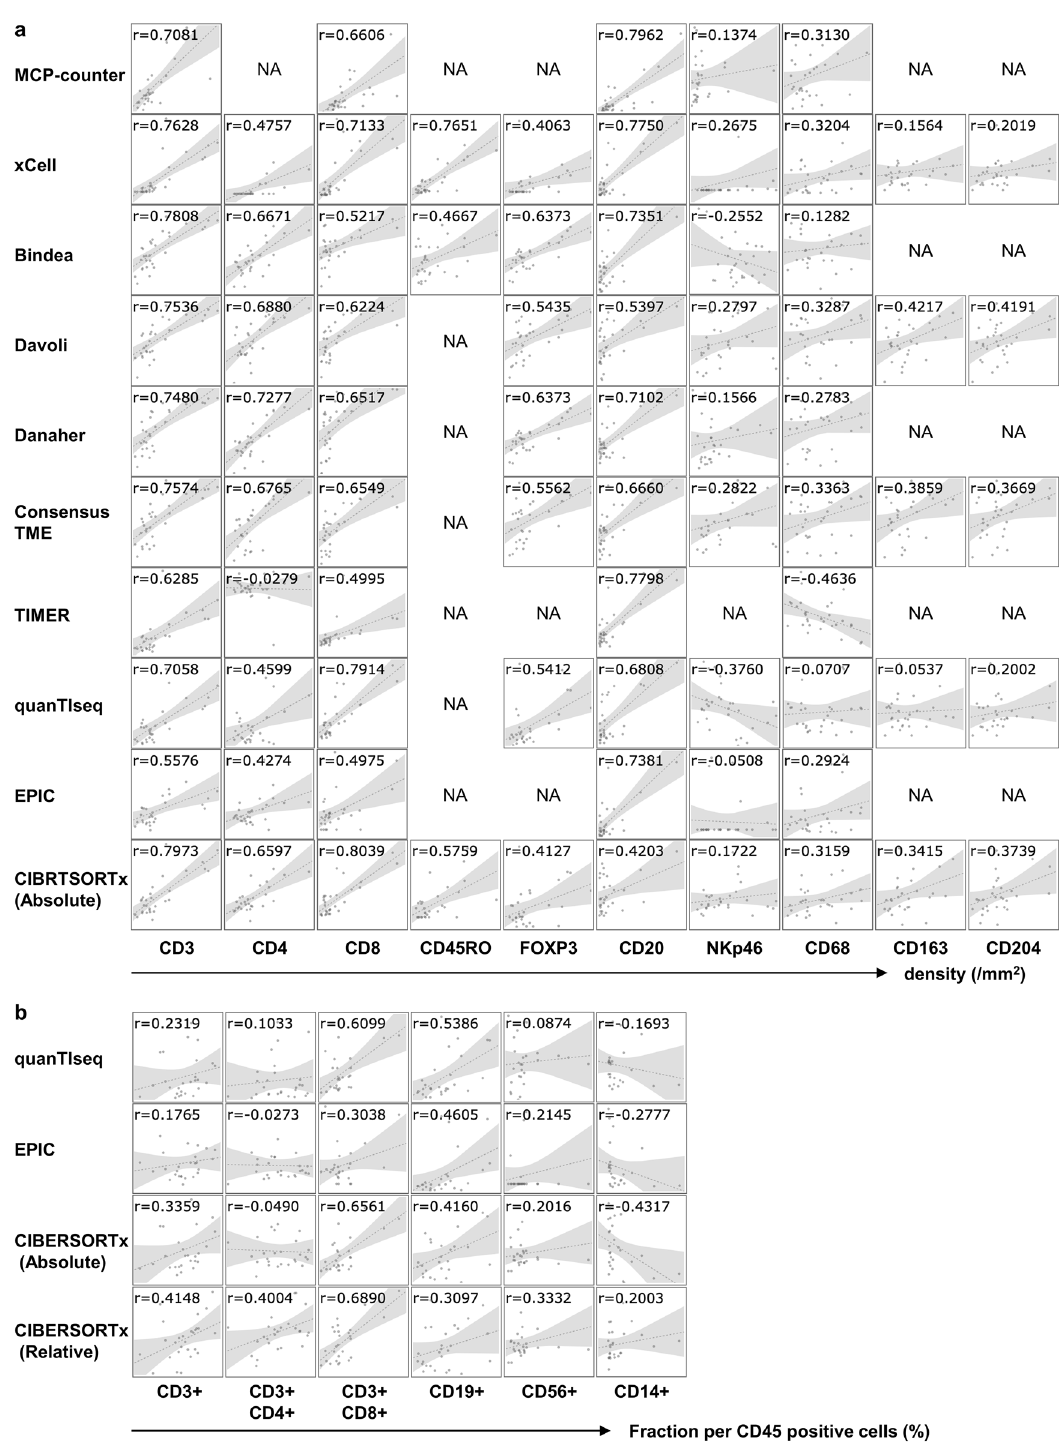
Figure 1. Correlation between transcriptome-based quantification methods and IHC or FCM. The vertical axis shows arbitrary scores obtained by the indicated computational method for RNA-Seq. ( a ) The horizontal axis shows the densities of immune cells detected by the indicated antibodies (/mm 2 ). ( b ) The horizontal axis shows the percentages of the indicated antibody-positive cells in the sample as assessed by FCM. The Pearson’s correlation coefficient (r) between the two is shown in the upper part of each scatter plot. Transcriptome- based cell quantification methods for inter-sample comparison were validated with IHC ( a ) and intra-sample comparison with FCM ( b